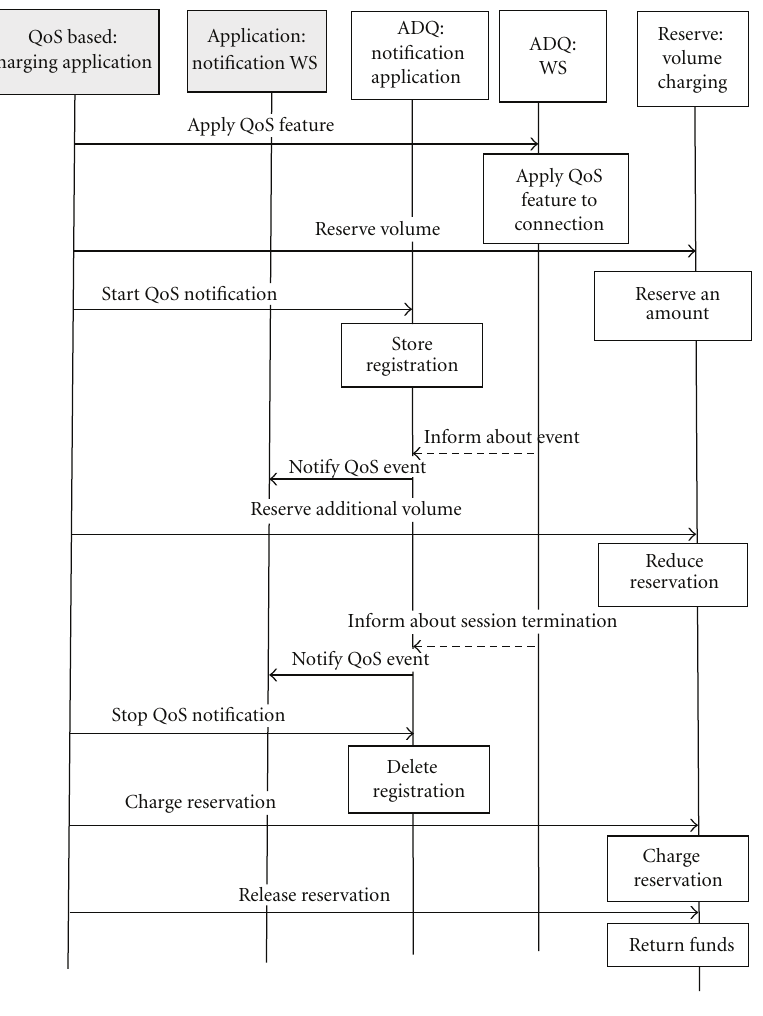
Figure 8: Use case of QoS-based